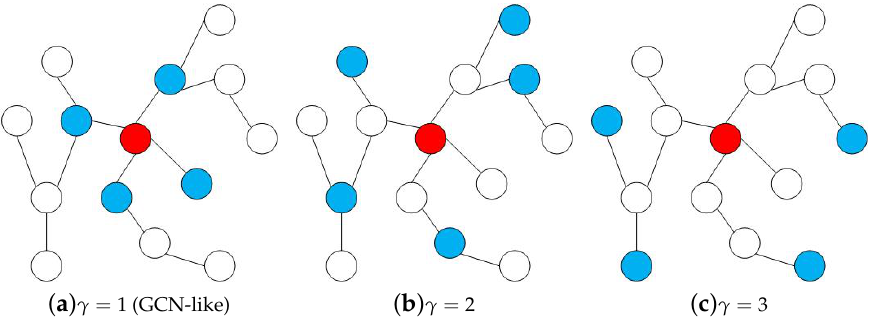
Figure 4. An example for graph dilated convolution kernel with different values of γ . The red node refers to the center node, and the corresponding neighborhood of the center is constructed by the blue nodes. Note that when γ = 2, only the neighbors in exact 2-hops are